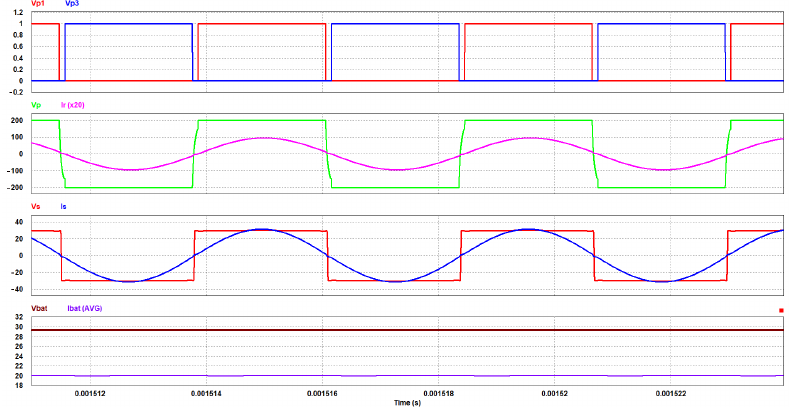
Figure 11. LLC resonant converter FM simulation V o = 29.4 V, I o = 20 A, f sw = 218 kHz. The resonant operation is accomplished at 218 kHz switching frequency which is defined by the modeling study and the available transformer inductance and resonant capacitor values.